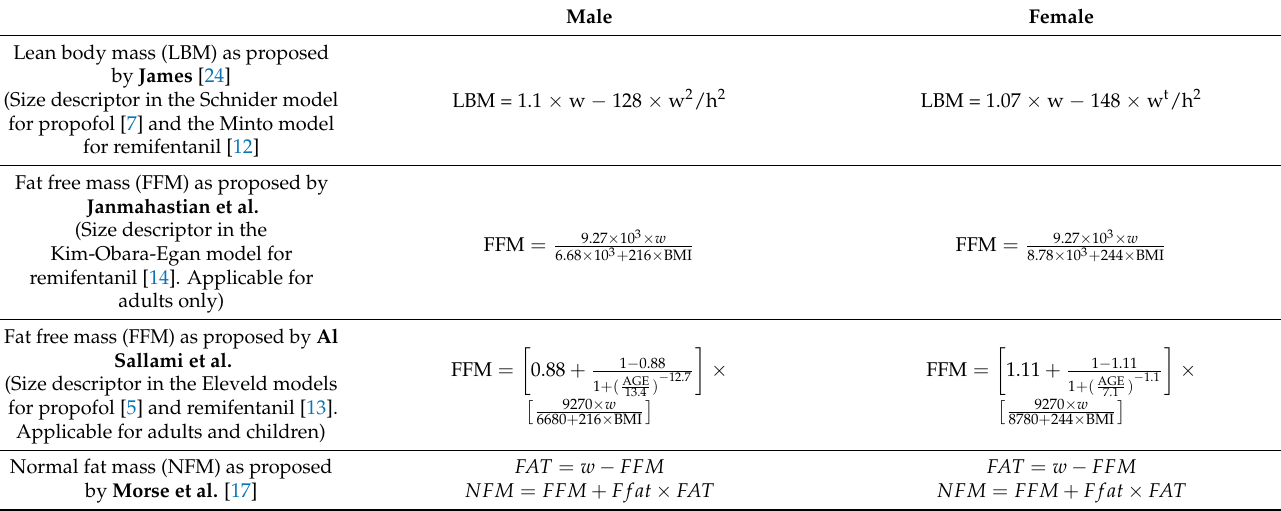
Table 2. Different equations to define the size of patients. Male